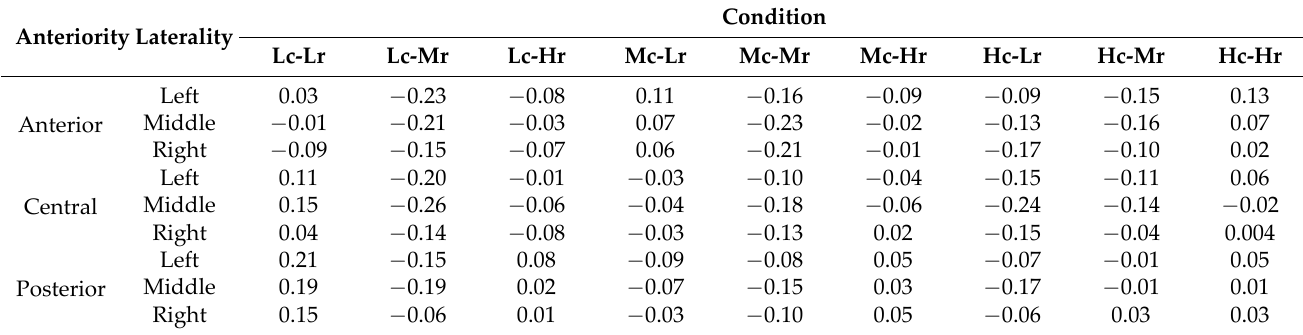
Table 1. Descriptive statistics of N1 electrophysiological results.